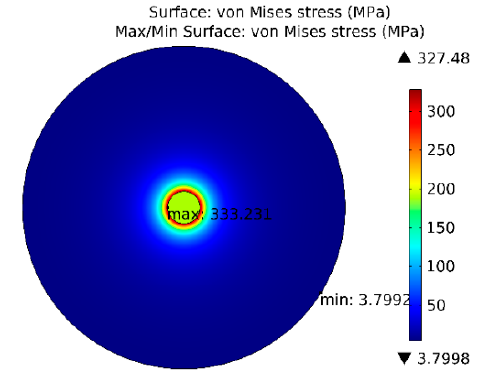
Figure 4. Mechanical stress distribution at standstill of the M270-35A-made rotor (teeth are not shown).